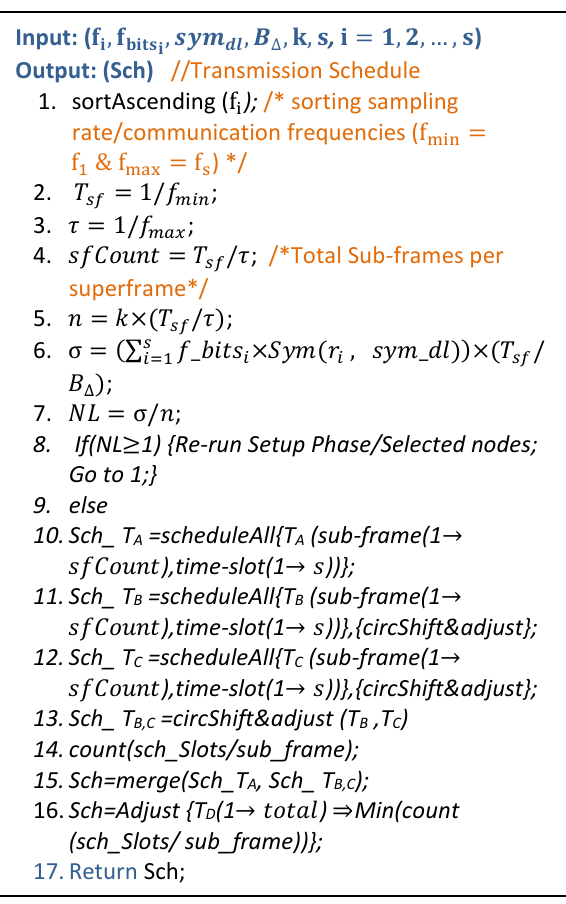
Algorithm 1: Schedule formation for